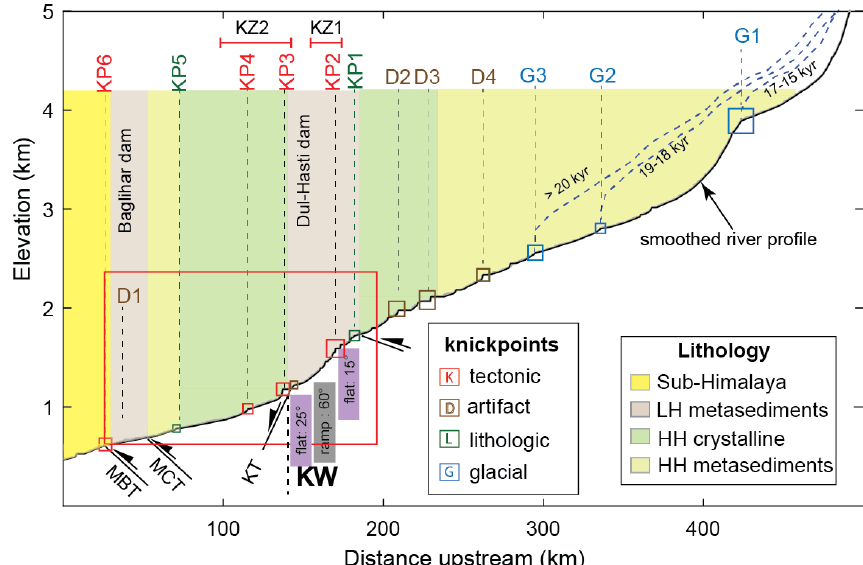
Figure 6. Longitudinal profile of the Chenab River showing major changes in channel gradient associated with knickpoints upstream. It illustrates that the major changes in the channel gradient extend over the full length of the KW, and the strongest changes are located in the core and not at the margins of the window. We classified knickpoints on the basis of their genesis. The substrate lithology along the river is shown. Knickpoints caused by glacial occupancy (G1, G2 and G3) are adapted from Eugster et al. (2016), who reconstructed the timing of maximum glaciation and extent of glacial cover in the source region of the upper Chenab River basin during the Last Glacial Maximum. These knickpoints highlight the importance of glacial erosion in the high-elevation sectors, especially in the northern tributaries of the Chenab River. Further in this study, we focus on the area marked by the red